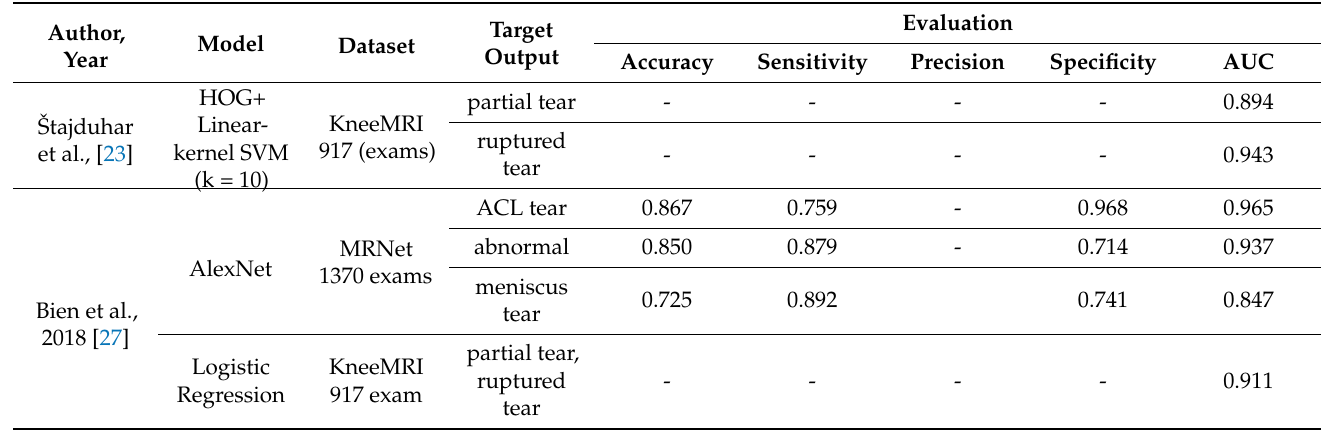
Figure 9. The confusion matrix comparison of six approaches class balancing and data augmentation: ( a ) without class balance and augmentation 5-fold cross validation; ( b ) without class balance but augmentation 5- fold cross validation; ( c ) class balance without augmentation; ( d ) class balance but augmentation; ( e ) class balance and augmentation 3-fold cross validation ( f ) class balance and augmentation 5-fold cross validation. Table 7. Comparison state of the art works with our proposed